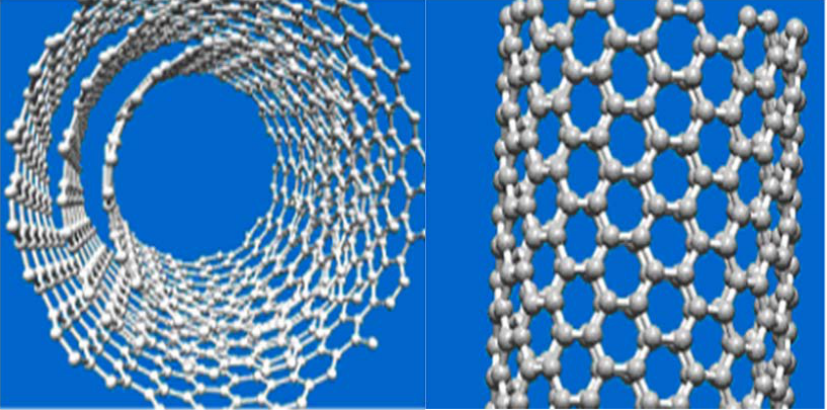
Figure 8. The image on the left is a three-dimensional model of a single-walled carbon nanotube (SWCNT). The image on the right is three SWCNTs concentrically aligned on top of one another, also known as a multi-walled carbon nanotube (MWCNT) (Reprinted with permission from Ganesh, E.N. [64]. Copyright 2013, CC BY NC ND 4.0 International).